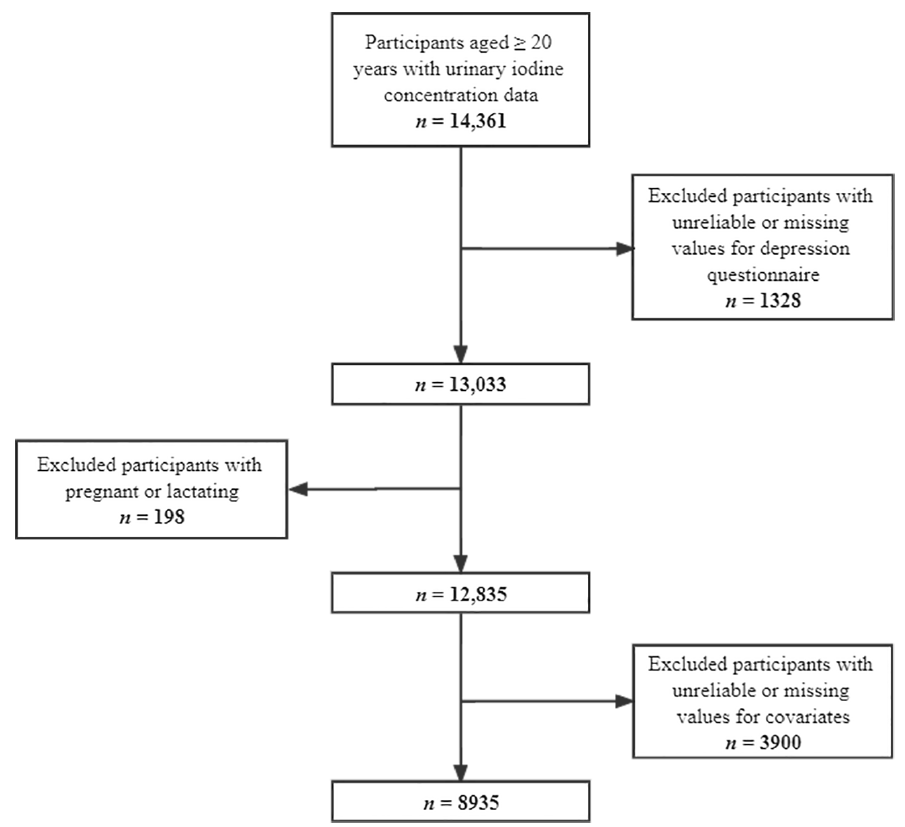
Figure 1. Flow chart of the screening process for the selection of eligible participants.